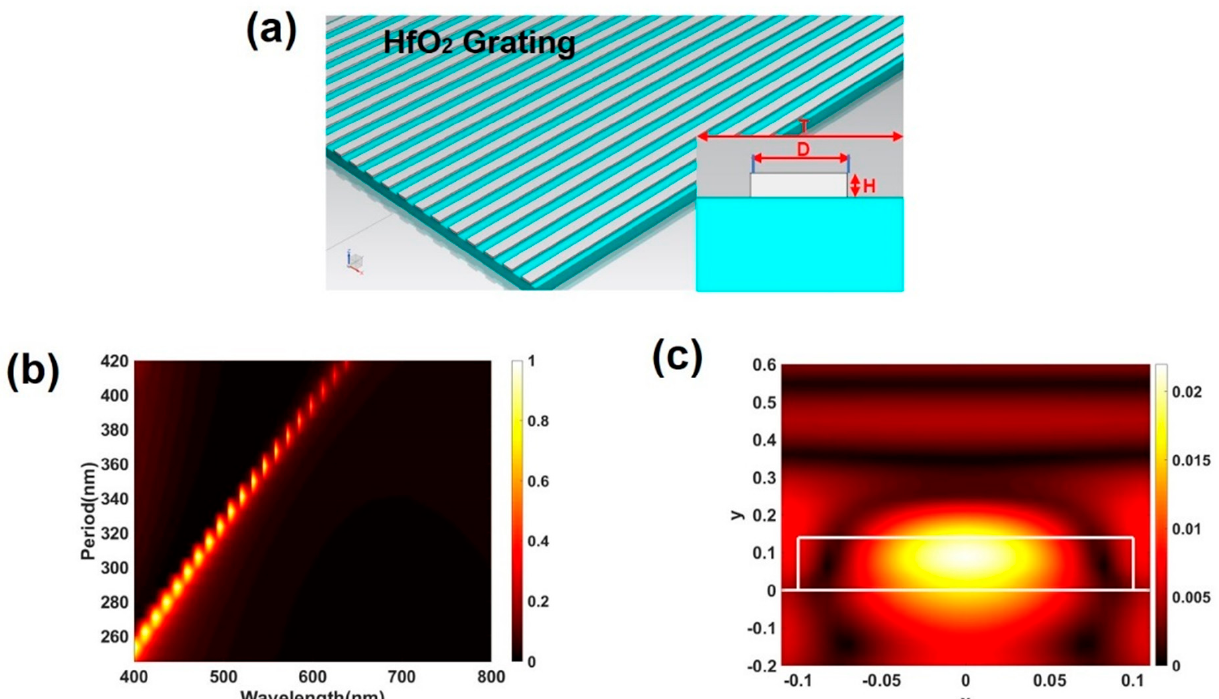
Figure 1. ( a ) Schematic diagram of the HfO2 grating structure; ( b ) with a fixed duty ratio (D/T = 4/7) and grating thickness (H = 140 nm), the grating period T (from 240 nm to 420 nm) was swept; ( c ) the magnetic field distribution at the grating period T = 385 nm and the resonance peak λ = 533 nm. After the incident light was filtered by the filter, the non-resonant region in the reflection spectrum was filtered, and the processed incident light was incident into the grating structure at the same incident angle θ (relative to the filter and grating), thereby improving the quality of the structure color, as Figure 2 shows. In order to cut off the short-wave region of the reflection spectrum, we used the thin film design software Essential Macleod to design filters with three different film systems. The initial film systems of the filters were respectively (0.5 L/H/0.5 L) n . The coefficient n is an adjustment factor for the filter steepness, and the larger the coefficient, the higher the filter steepness. The high and low refractive index materials were tantalum pentoxide (Ta 2 O 5 ≈ 2.14) and silicon dioxide (SiO 2 ≈ 1.46), respectively.